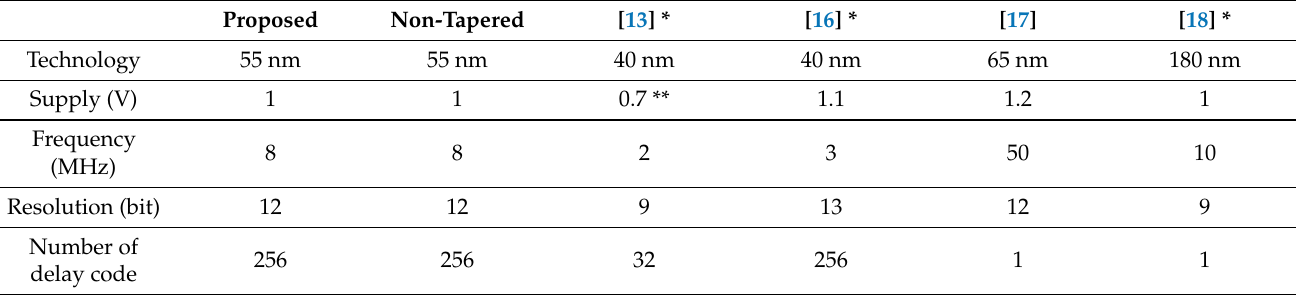
Table 2. Performance comparison